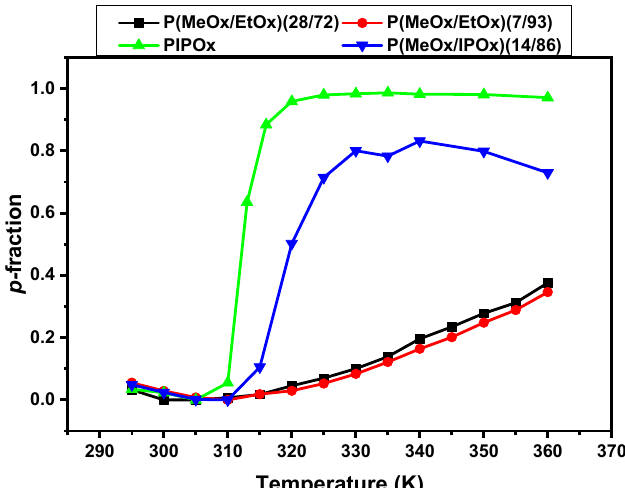
Figure 5. Temperature dependencies of the fraction p of units with significantly reduced mobility for NCH 2 protons in D 2 O solutions ( c = 5 wt%) of PIPOx homopolymer (green) and P(MeOx/IPOx)(14/86) (blue), P(MeOx/EtOx)(28/72) (black), P(MeOx/EtOx)(7/93) (red) copolymers during gradual heating.